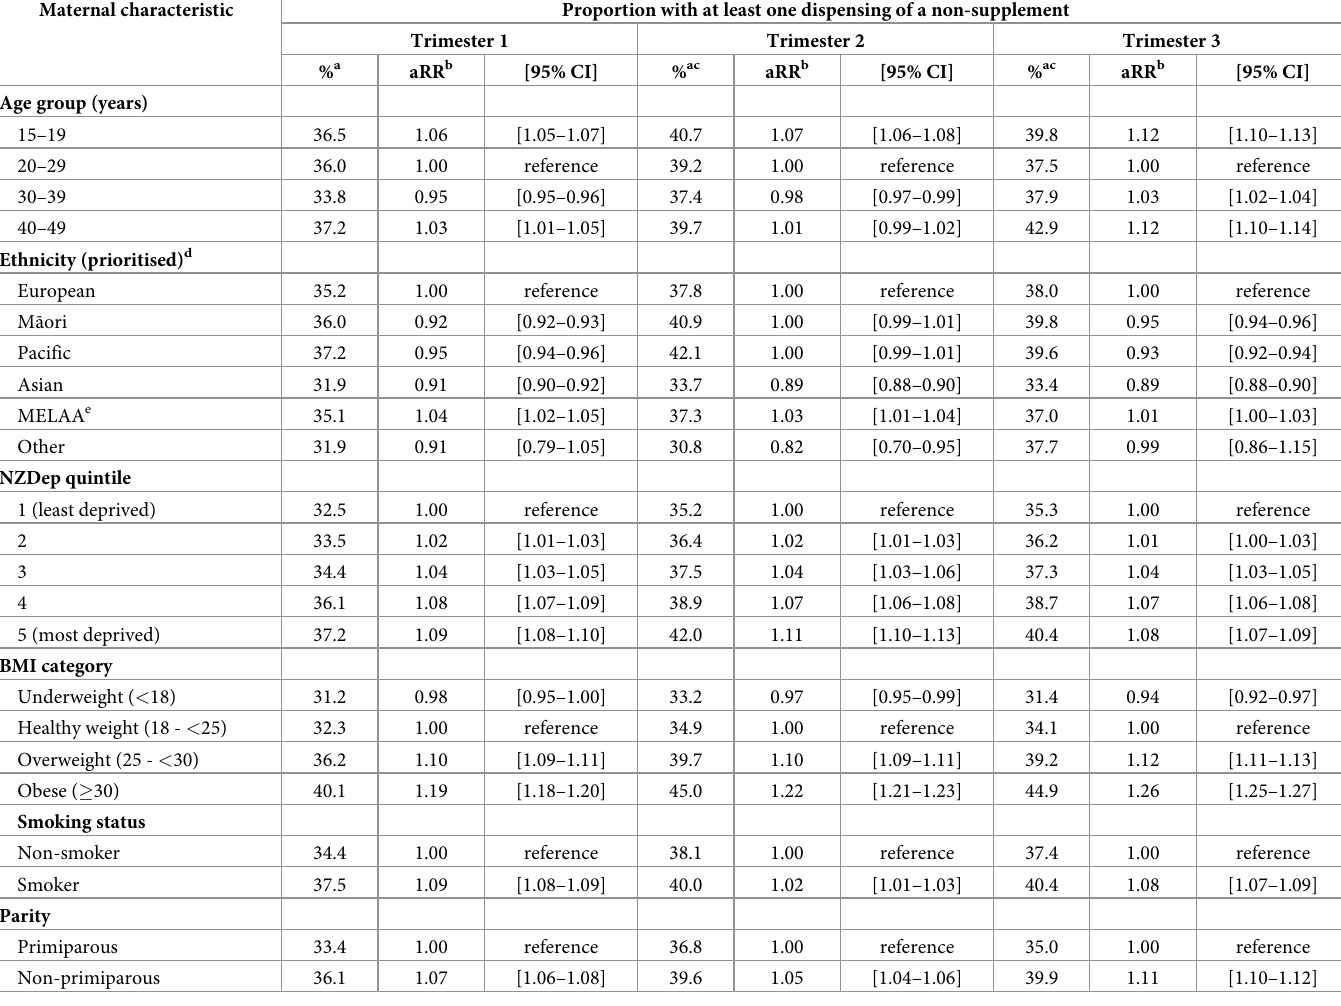
Table 3. The proportion of pregnancies with � 1 dispensing of a non-supplement prescription medicine during each of the pregnancy trimesters, by maternal